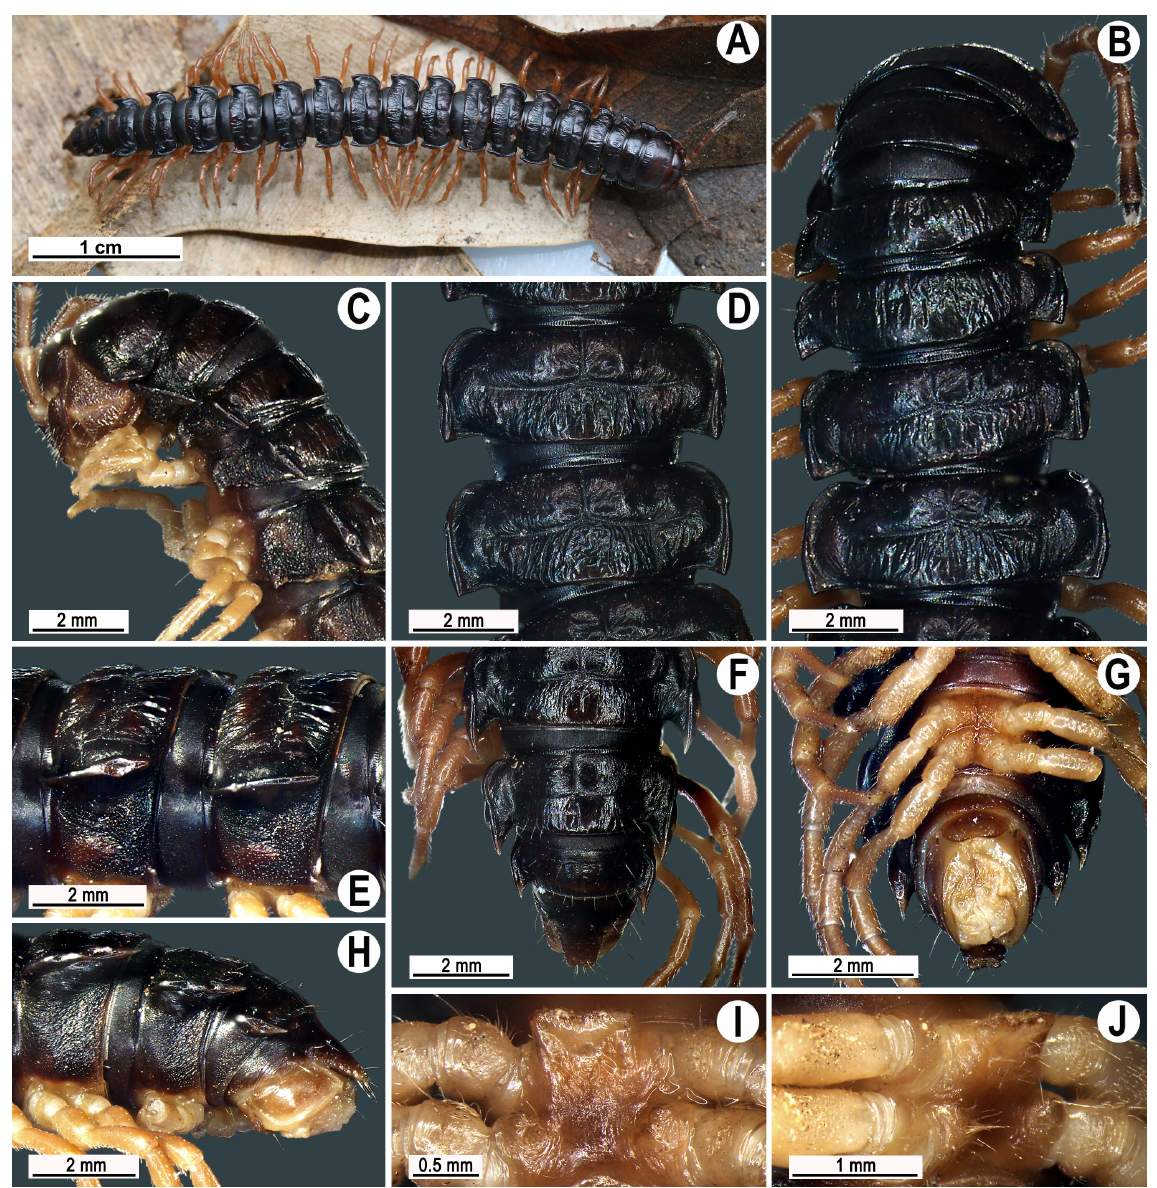
Fig. 23. Tylopus baenzigeri Golovatch & Enghoff, 1993, ♂. A . habitus, live coloration. B–C . anterior part of body, dorsal and lateral views, respectively. D–E . Segments 10 and 11, dorsal and lateral views, respectively. F–H . Posterior part of body, dorsal, ventral and lateral views, respectively. I–J . Sternal cones between coxae 4, subcaudal and sublateral views,